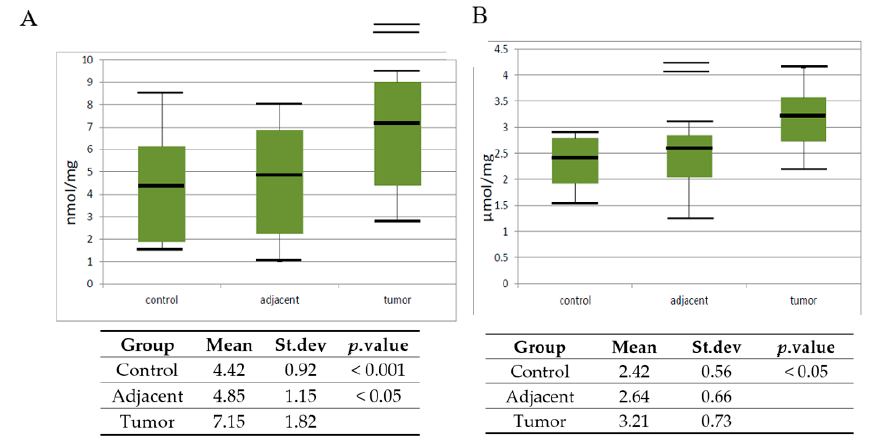
Figure 3. Vertical boxplot for ( A ) thiobarbituric acid reactive substances (TBARS) and ( B ) advanced oxidation protein products (AOPP) in control healthy tissue, tissue adjacent to tumor and tumor prostate tissue. The median is identified by a line inside the box, the boundaries of the box are interquartile range (IQR). Bars = entire range. Values more than 75th percentile are labelled as extreme and denoted as the horizontal lines beyond the